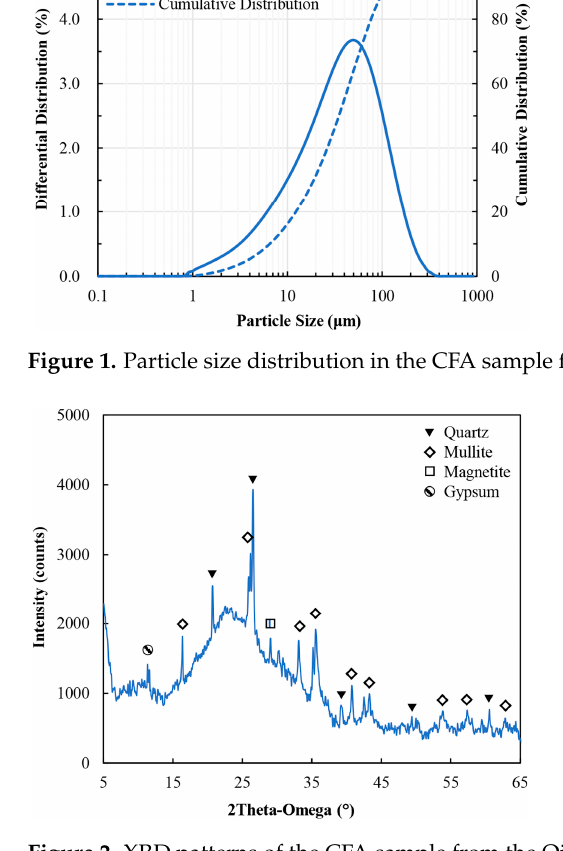
Figure 2. XRD patterns of the CFA sample from the Qianxi power plant in Guizhou.